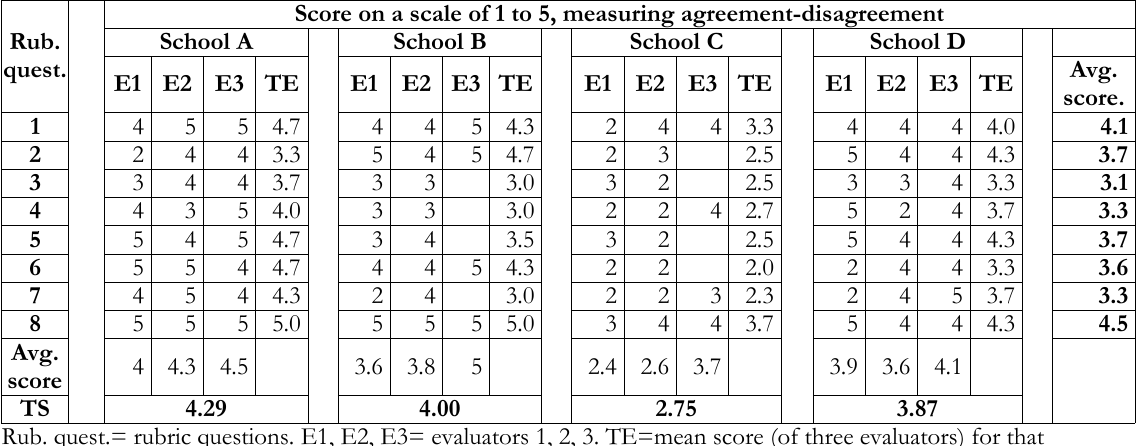
Table 2. Results of the evaluation by the professors associated with the project and outside evaluators, according to the indicators included on the